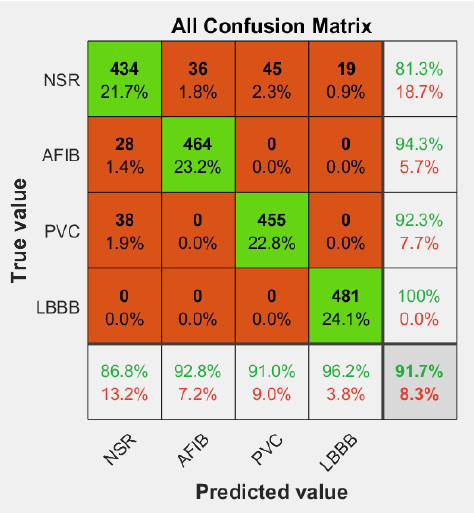
Figure 10. Results of arrhythmia detection using an ensemble network. Red color indicates cases of misclassification. Green indicates exact classification. Gray indicates the classification result. The values at the end of each row and column indicate accuracy and error rate.